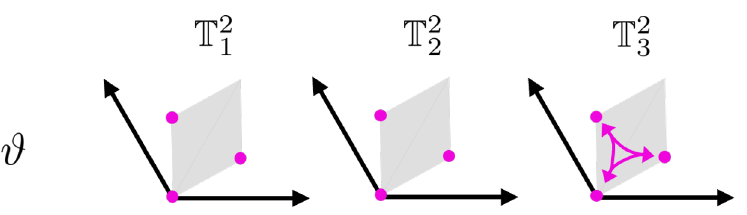
Figure 11 . An illustration of the fixed points in the Z 3 × Z 3 − 1 − 4 orbifold. Their location in the three tori is denoted pink and identification is indicated by